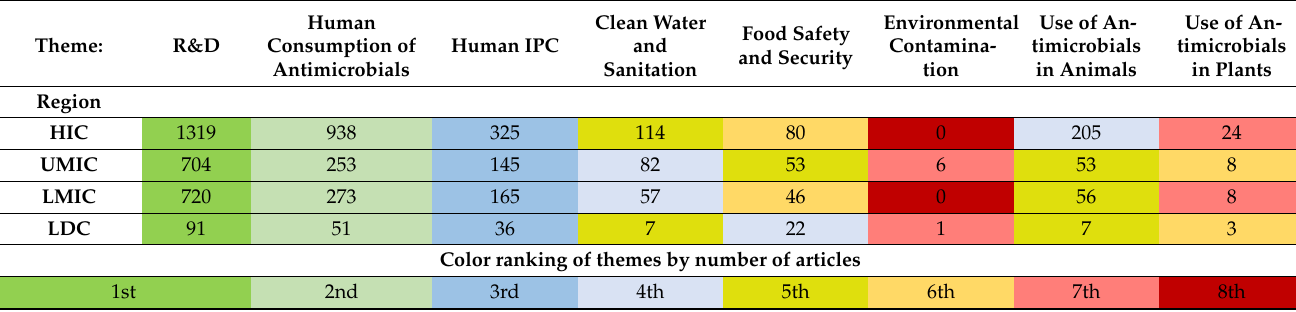
Table 7) and “clean water and sanitization” (3.2%, n = 7; Table 7). Table 7. AMR theme distribution of article records and ranking by income level ( n =